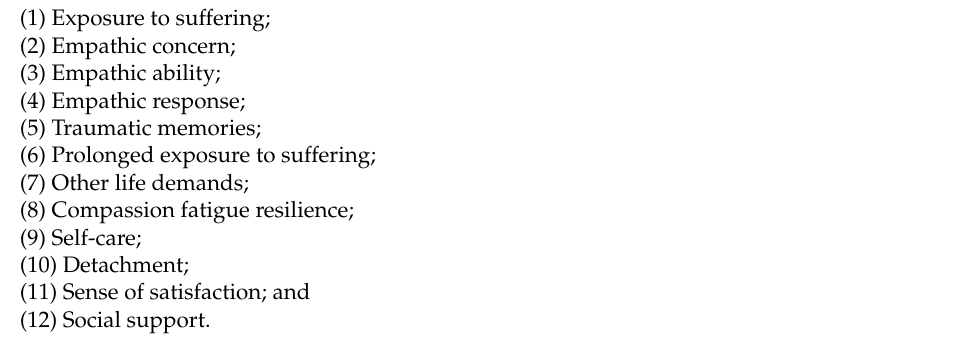
Table 1. STS 12-Factor